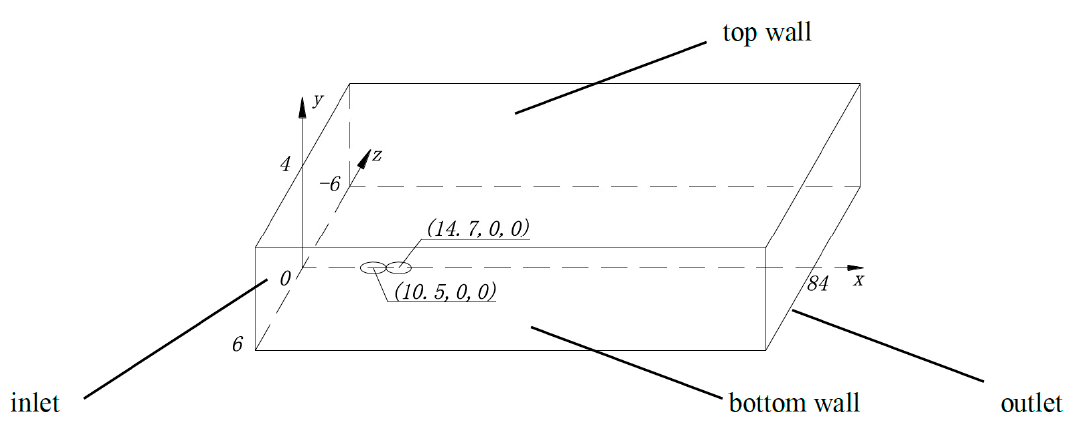
Figure 1. Distribution of initial disturbance at the wall.